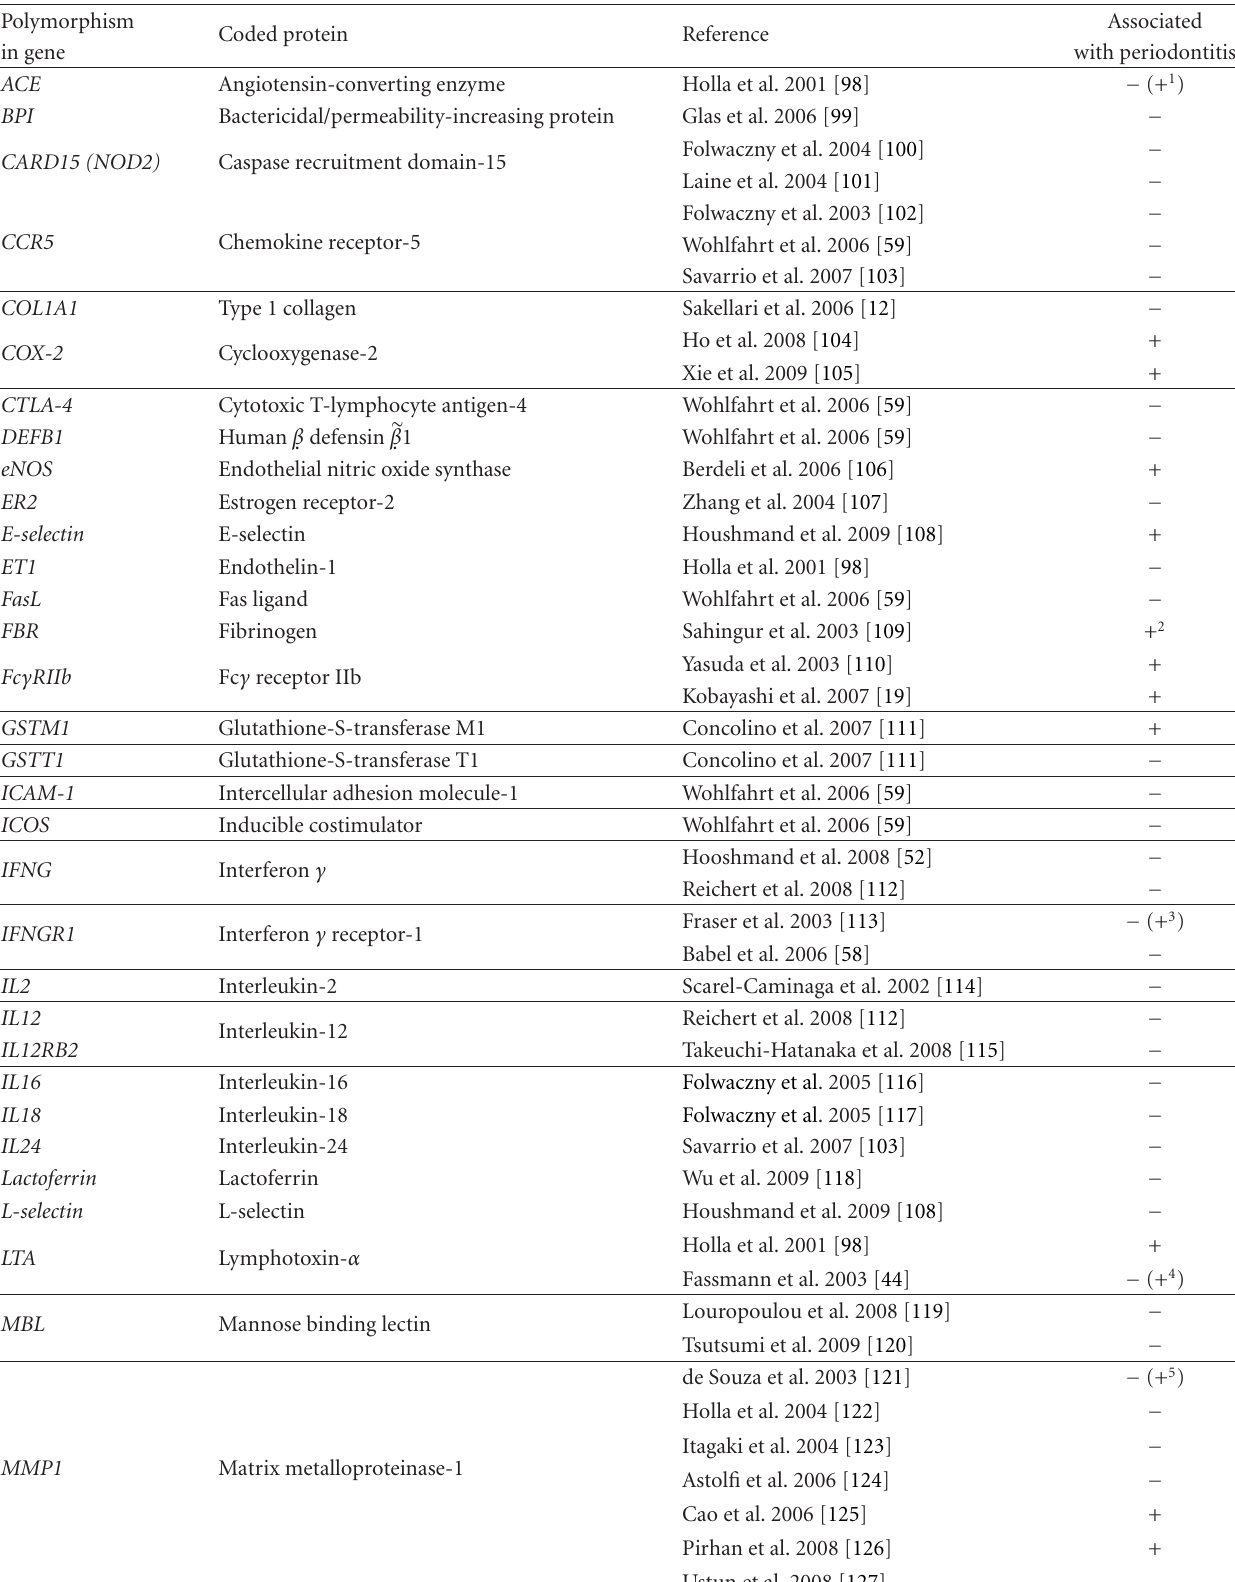
Table 12: Miscellaneous candidate genes and the corresponding encoded proteins studied in relation to susceptibility to chronic periodontitis and reported